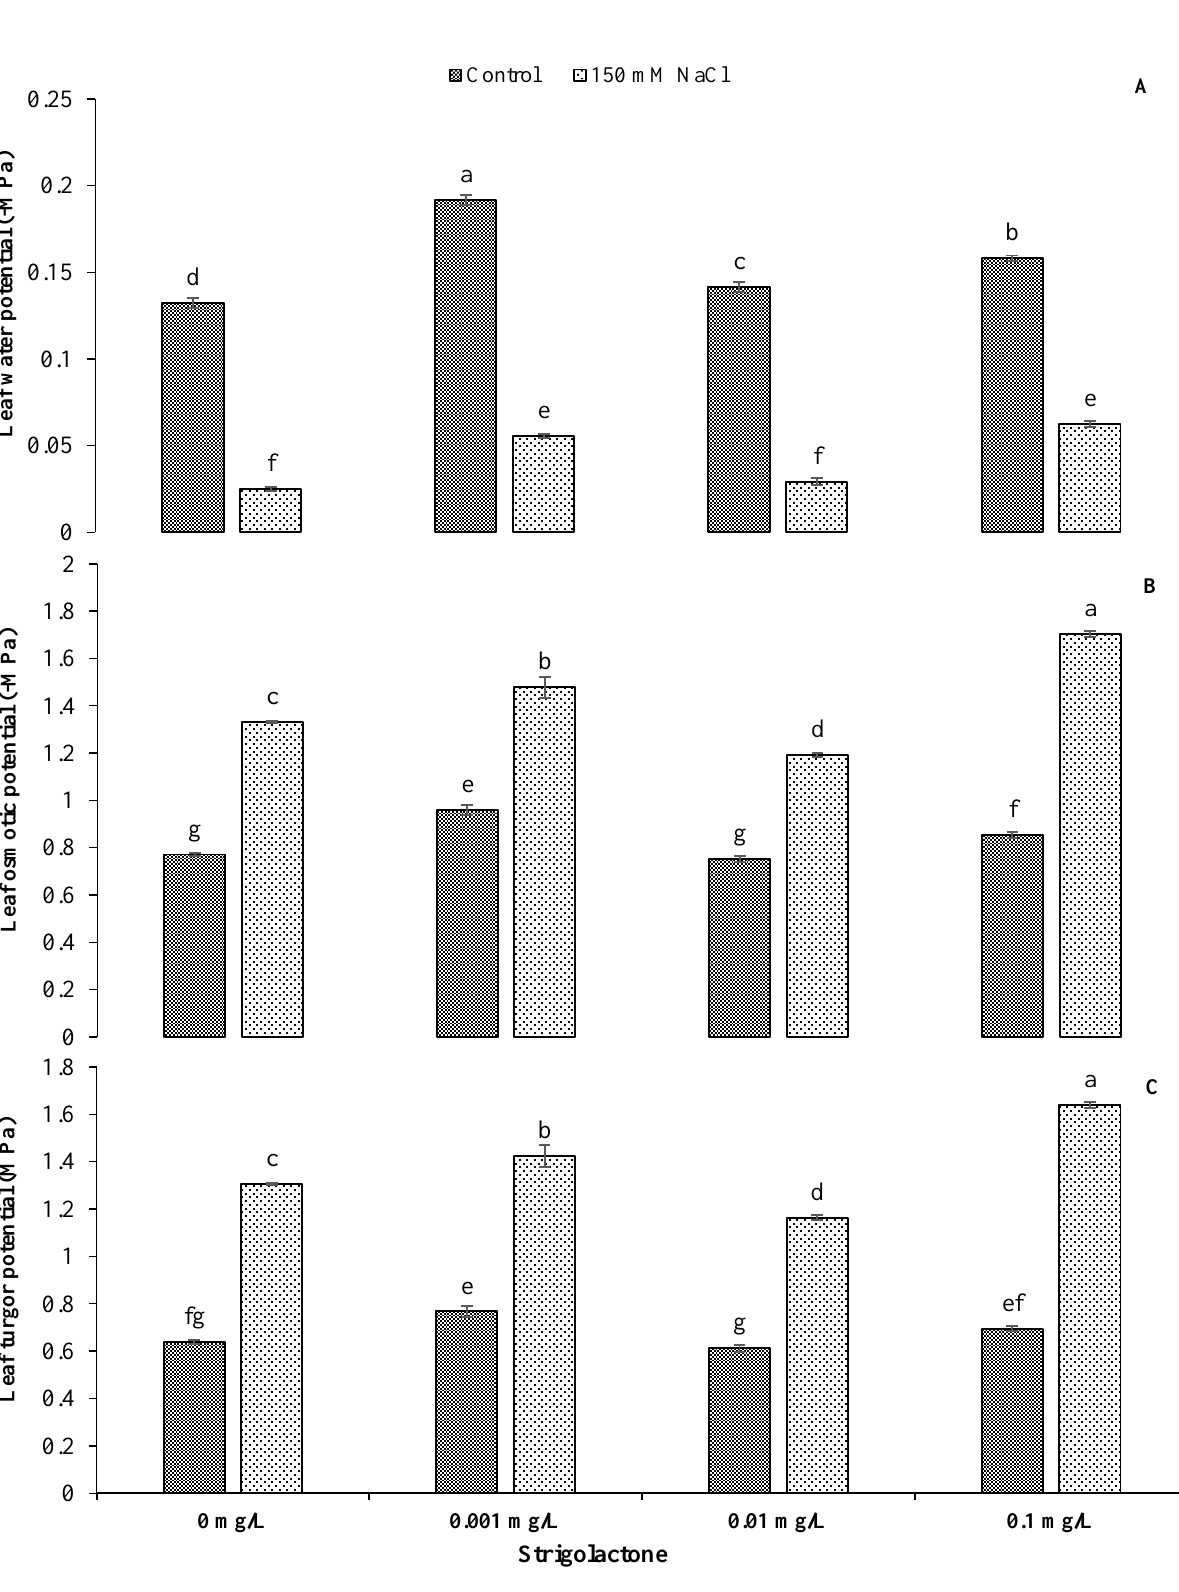
Figure 2. Impact of GR24 on leaf water potential ( A ), leaf osmotic potential ( B ) and leaf turgor potential ( C ) of ornamental sunflower under control and salt stress conditions. Each vertical bar shows the mean of three replicates. Different letters indicate significant differences among treatments at p ≤ 0.01 according to least significant difference test.